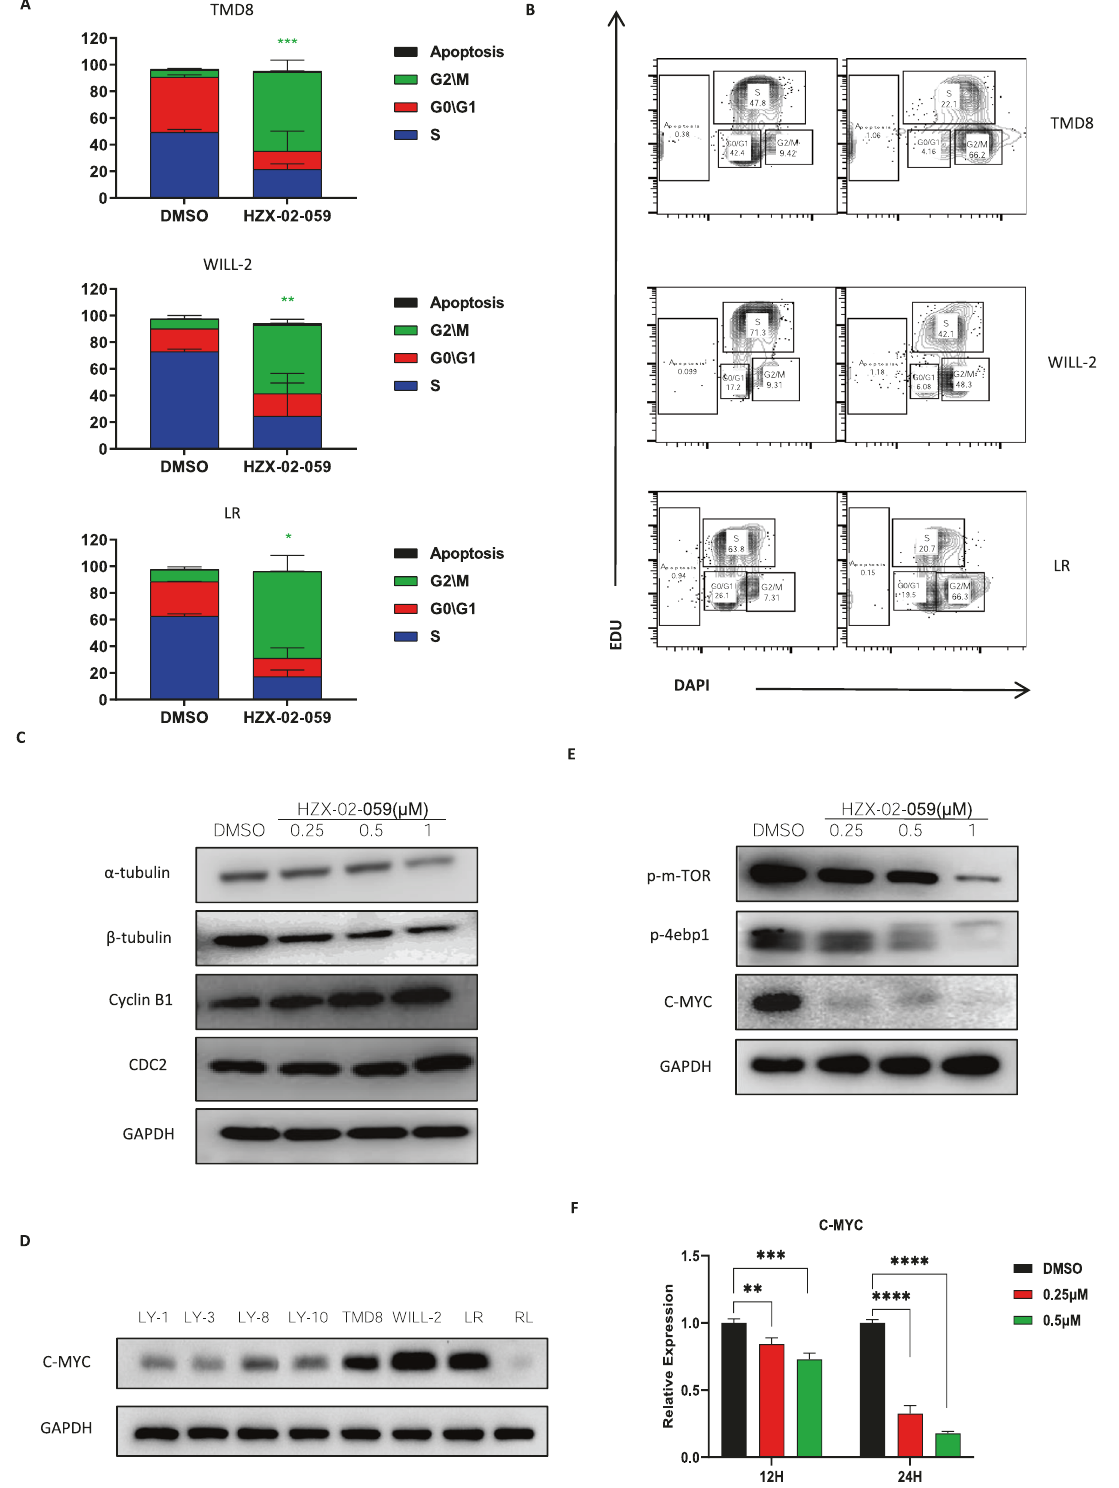
Fig. 5 HZX-02-059-induced cell death is also mechanistically associated with mTOR – Myc axis. A , B DHL cell lines were exposed to 0.5 μ M HZX-02-059 for 24 h, after which cell cycle status was determined by FACS. Representative data ( A ) for fl ow cytometric analysis and histogram ( B ) were shown. C Cell cycle-related proteins, including Cyclin B1, Tubulin, and CDC2, were assessed by western blot analysis after drug exposure. D Expression level of MYC between DCLBC and DHL cell lines. E Protein levels in the mTOR/MYC signaling axis were also evaluated. GAPDH was served as a loading control. F Transcriptional level of C-MYC after HZX-02-059 treatment. Values indicate mean ± S.D. for at least three independent experiments performed in triplicate * P < 0.05, ** P < 0.01, *** P < 0.001.